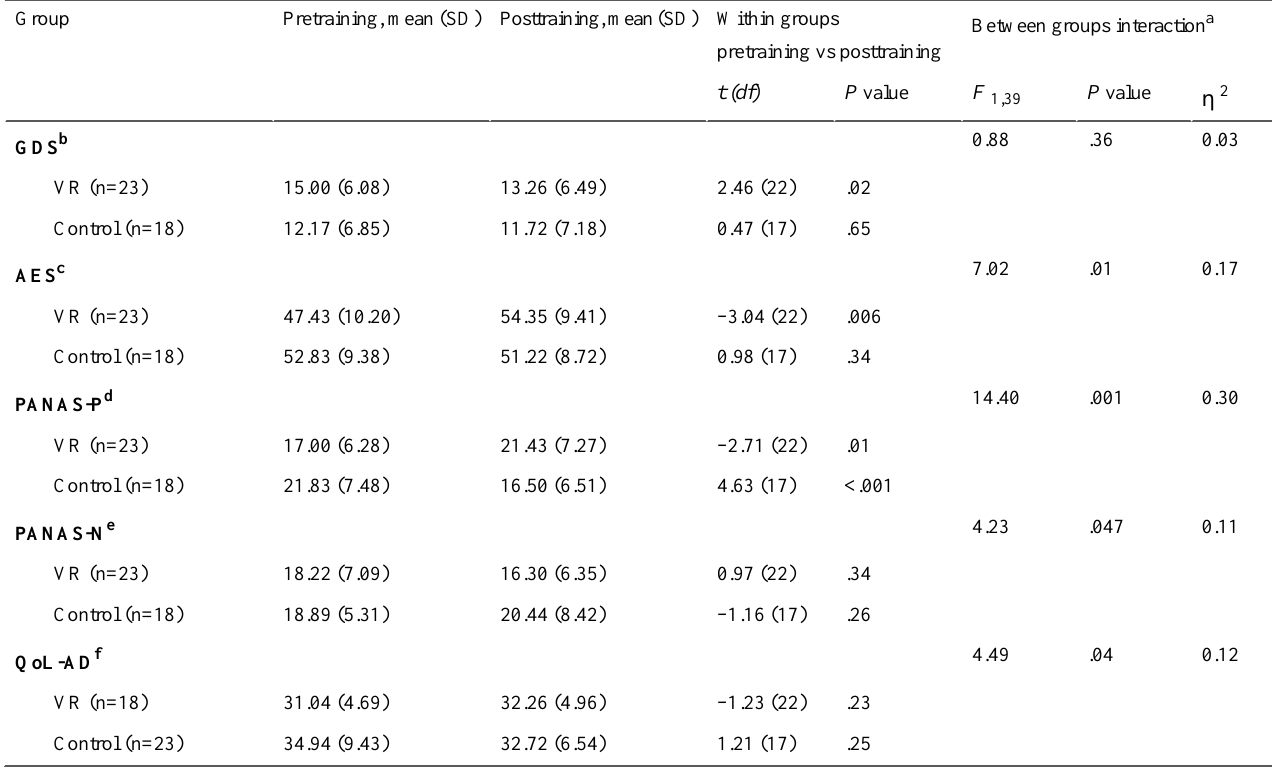
Table 4. Group comparisons of psychiatric symptoms pre and post virtual reality (VR) cognitive